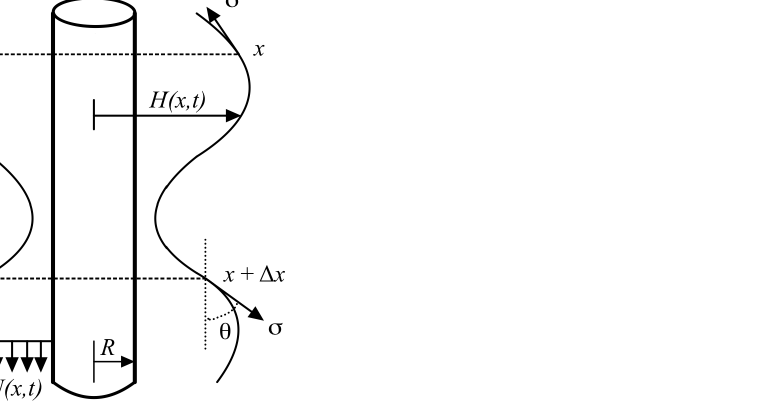
Figure 1. Schematic plot of a liquid film on a fiber. The axial coordinate along the fiber axis is x , and the radial distance from that axis is r